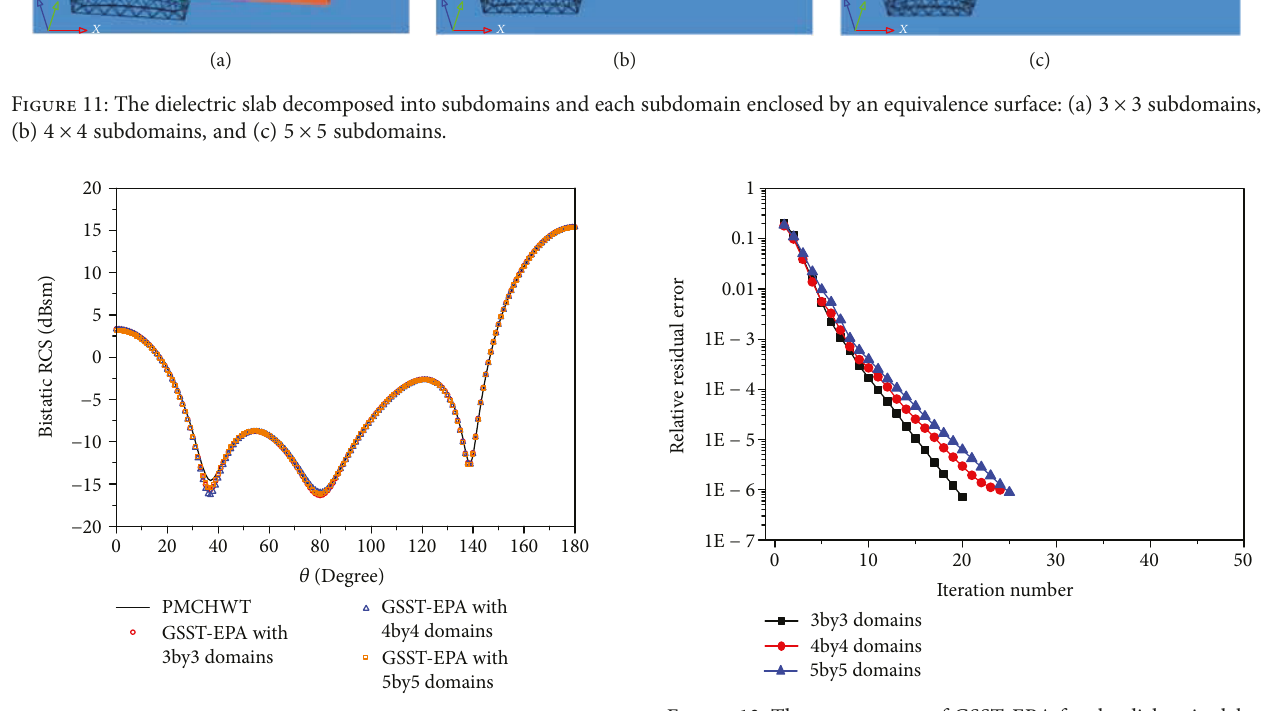
Figure 12: The bistatic RCS of a dielectric slab at 300MHz, HH polarization.